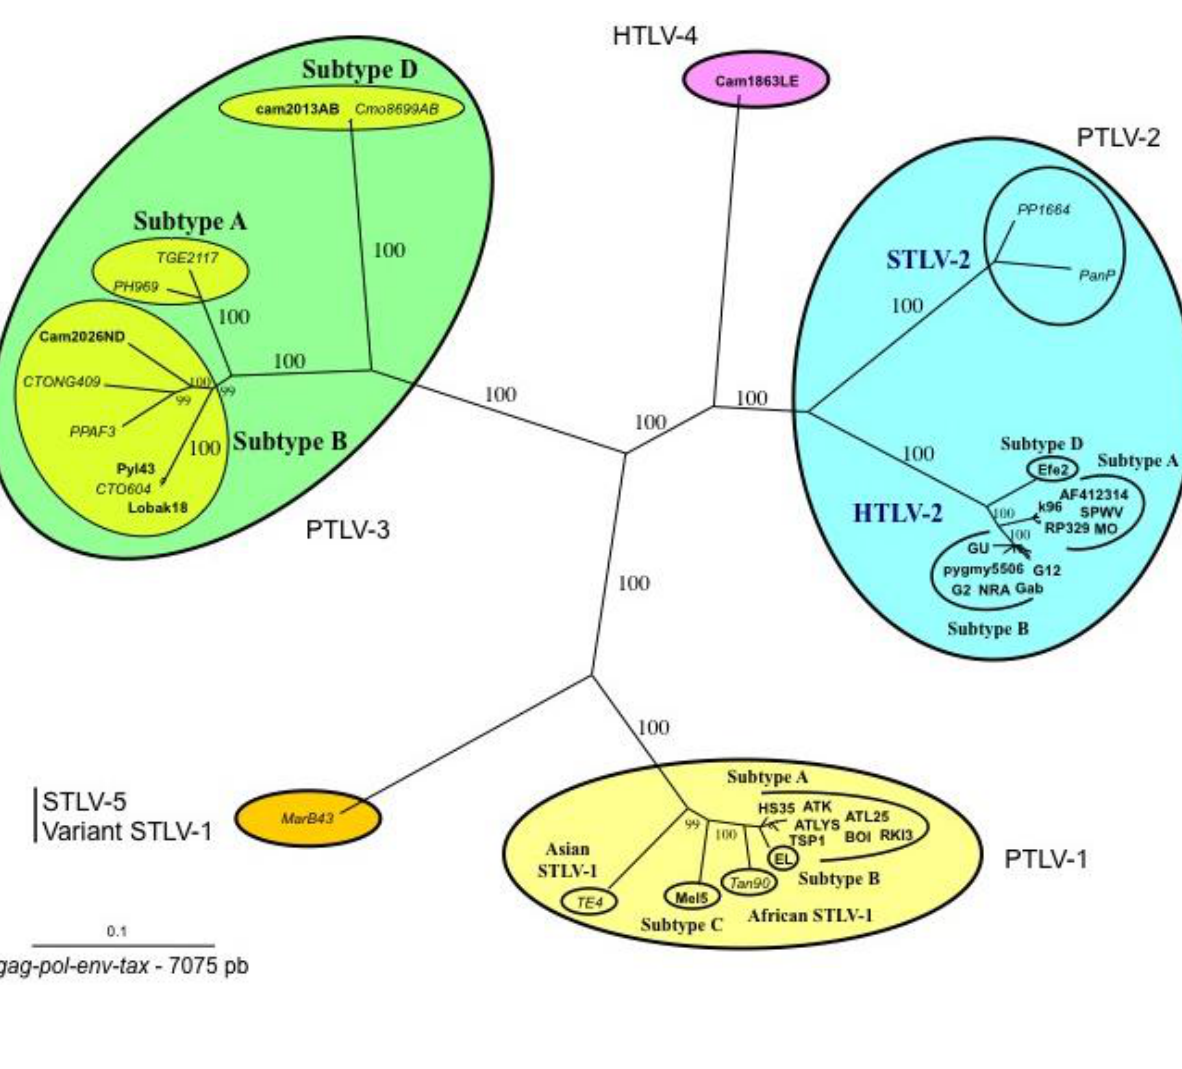
Figure 2. Phylogenetic tree showing the relationship between PTLV-1, PTLV-2, PTLV3, and HTLV-4. Unrooted tree generated with the neighbor-joining method, performed with the PAUP program using the 7075 bp of the concatanated gag-pol-env-tax genes with all the complete sequences of PTLVs available in GenBank. Branch lengths are drawn to scale. The human HTLV-3 and HTLV-4 strains are indicated in bold. Recent data based on shorter fragments of more STLV-3 strains confirmed that PTLV-3s are separated according to their geographical origin with four main distinct lineages (A, B, C, D). Mac B43 strain is a highly divergent STLV-1 originating from Macaca arctoides . It is considered as an STLV-5 by some authors due to its great genetic diversity compared to STLV-1/HTLV-1